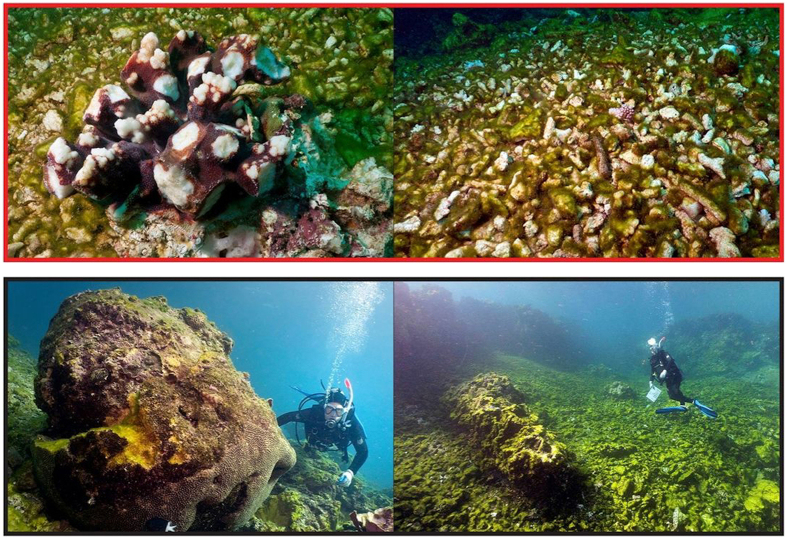
Photos representative of severe damage for our analyses of model performance in predicting where cyclones damage coral reefs.These were taken by Roger Beeden following TC Yasi, which crossed the GBR February 3, 2011 (see10, Fig. 4). The upper panel shows ‘severe’ damage where many (31–50%) colonies are dead or removed, there is extensive scarring by debris, there are rubble fields littered with small live coral fragments, soft corals are severely damaged or removed, and some large coral colonies are dislodged. The lower panel shows ‘extreme’ damage where most (51–100%) corals are broken or removed, soft corals are removed, and many large coral colonies are dislodged.